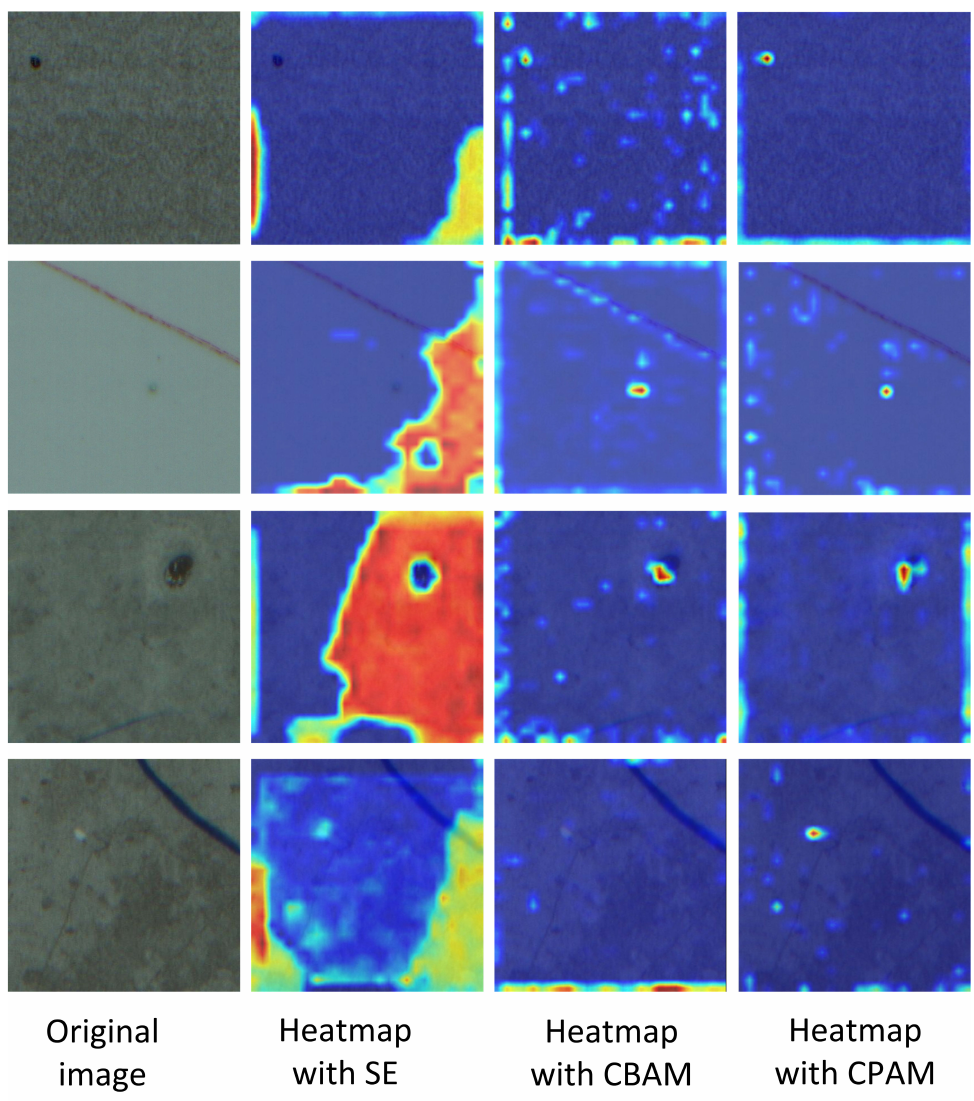
Figure 5. Heatmaps of different attention